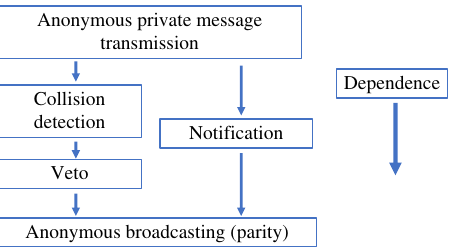
Fig. 3 Relationship between the protocols. A schematic that shows the dependence relationship between the protocols: anonymous broadcasting (parity) is the building block for all other protocols. The anonymous private message transmission requires collision detec- tion, veto, and noti fi cation; collision detection is also made up of two veto